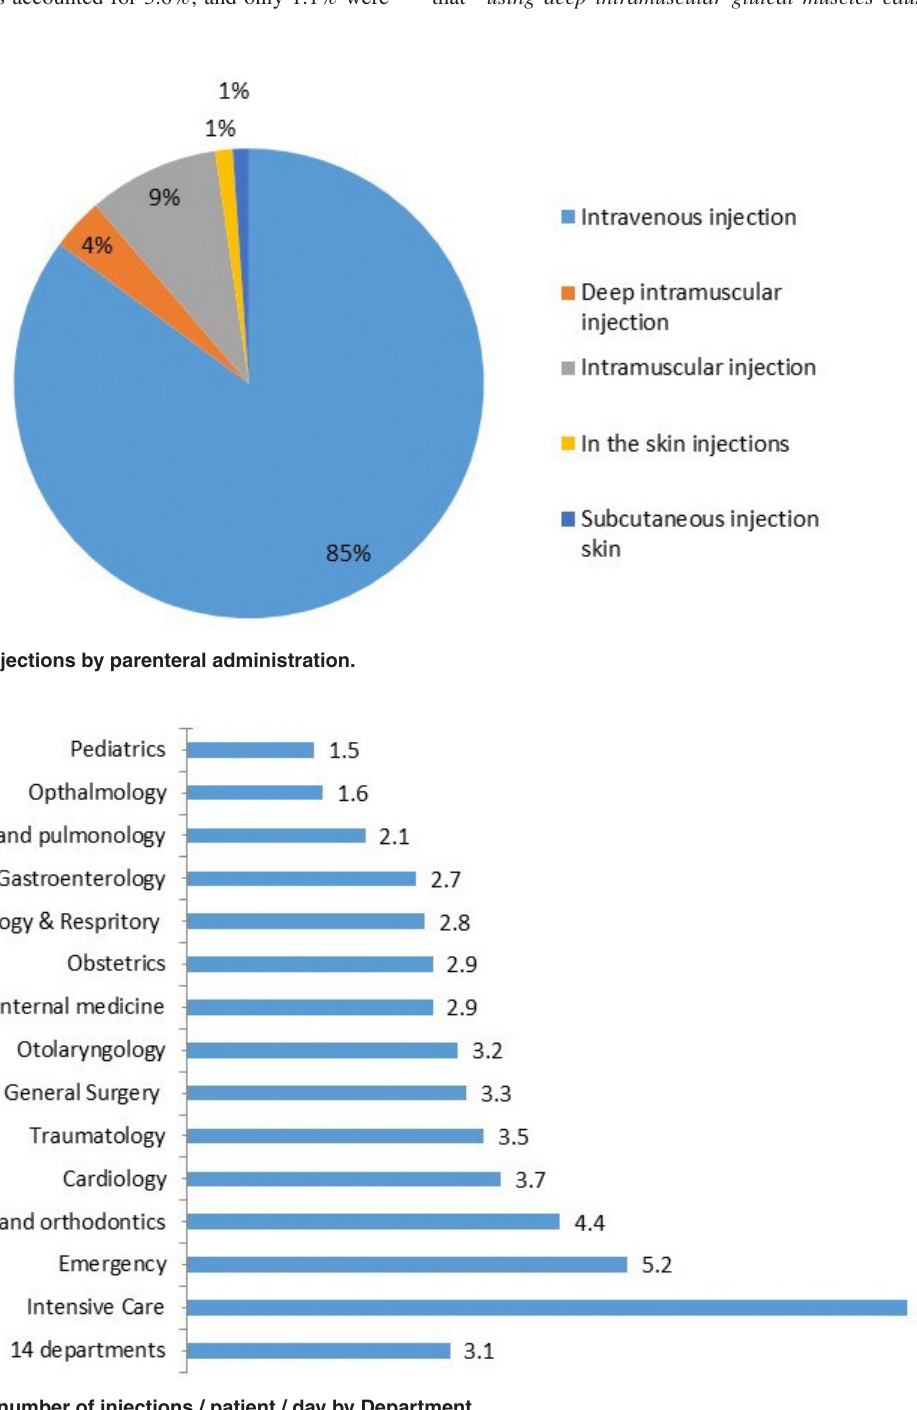
Figure 2. The average number of injections / patient / day by